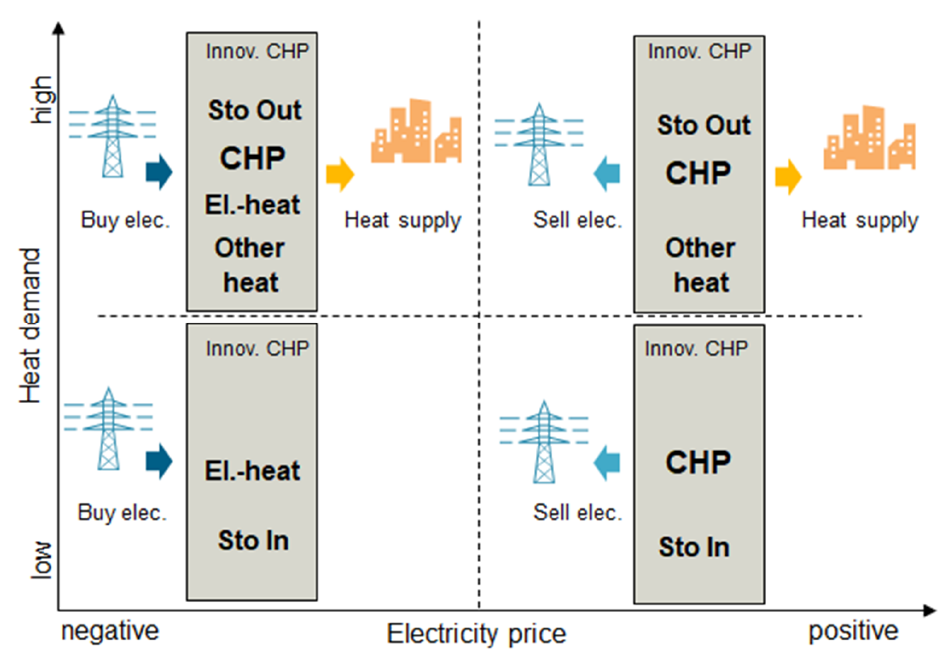
Figure 3. Overview of operation modes for innovative CHP solutions (figure adjusted from [41]). The design of each of these innovative CHP systems is based on a general rule which was derived from specific system optimizations. Therefore, different generation and storage technologies were available for an optimizer, i.e., the Energy System Development Planner (ESDP) (see [31]). The optimizer can then find the optimal combination and capacities of the different elements. Figure 4 on the left shows the idea of the optimization process. The components, which can be selected from the optimizer, are defined by their efficiencies and cost parameters (techno-economic parameters). The major constraint for the optimization process is the satisfaction of the thermal load (orange line) while maximizing the profits from selling and buying electricity at the spot market according to the simulated prices (blue chart). As there are many different heat sinks where new innovative CHP solutions could play a role, several typical situations were chosen and the systems were optimized accordingly. By taking the different results, a general rule for the design of the CHP systems was defined (see Figure 4 on the right) and applied to all heat sinks that remain without supply after the coal phase-out. The applied rule adds new CHP according to information of the required thermal power in each site. Figure 4 on the right shows the rule and the technologies that are applied. The model so far does not explicitly model operational flexibilities such as required time for restarts but this could be extended in future research, e.g., using an approach as described in Kryzia et al. [42], including the real options approach, the net present value method, and Monte Carlo